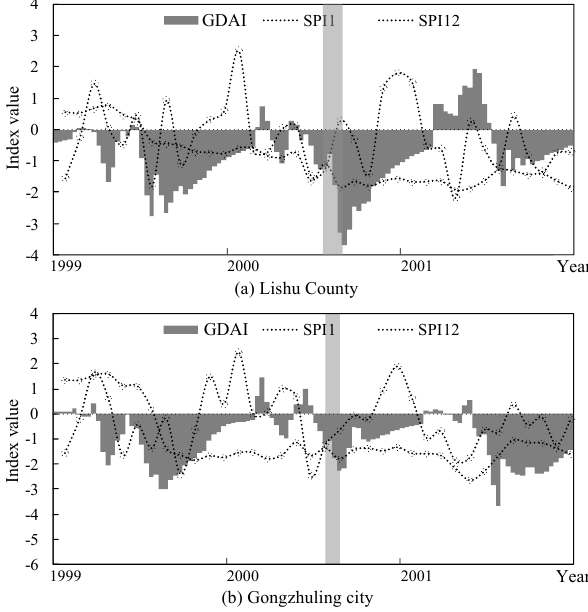
Figure 10. Compared the GDAI with the SPI from 1999 to